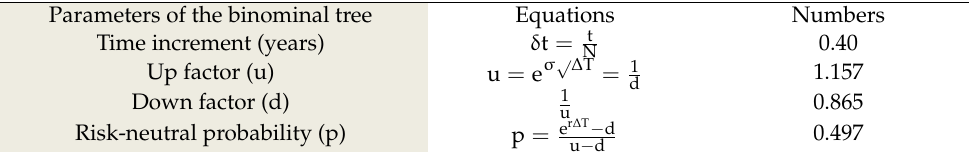
Table 5. Real Options Binomial Option pricing model parameters: Amazon.com acquisition of Souq.com.